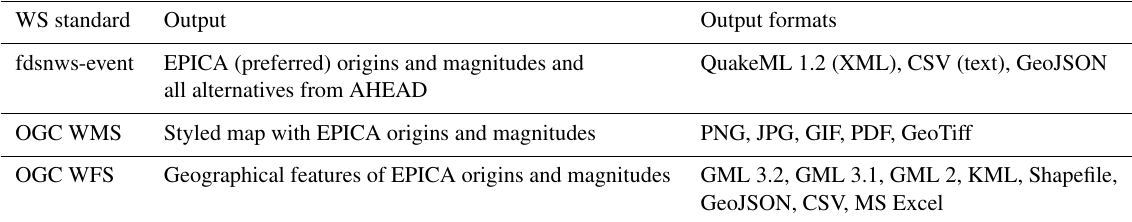
Table 6. Standards, outputs and output formats of the web services for accessing EPICA. WS